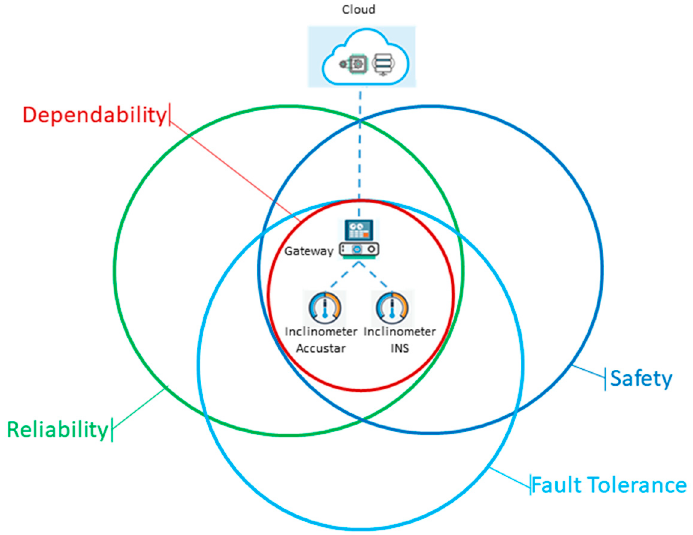
Figure 32. Conceptual view of Dependability pattern—If the Reliability, Fault Tolerance, and Safety properties of the orchestration hold, then the Dependability property specified in the pattern also holds.